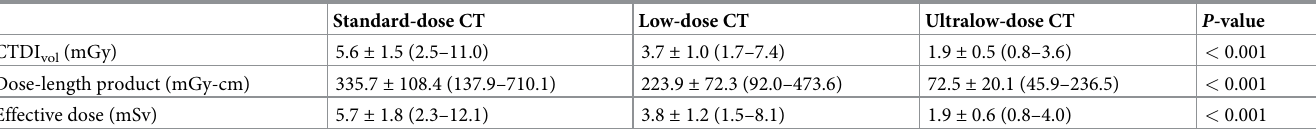
Table 6. Dose parameters of three CT image sets.